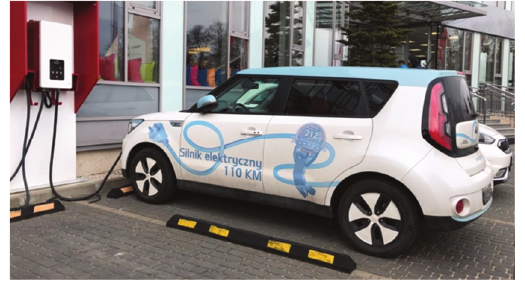
Fig. 1. Electric passenger car